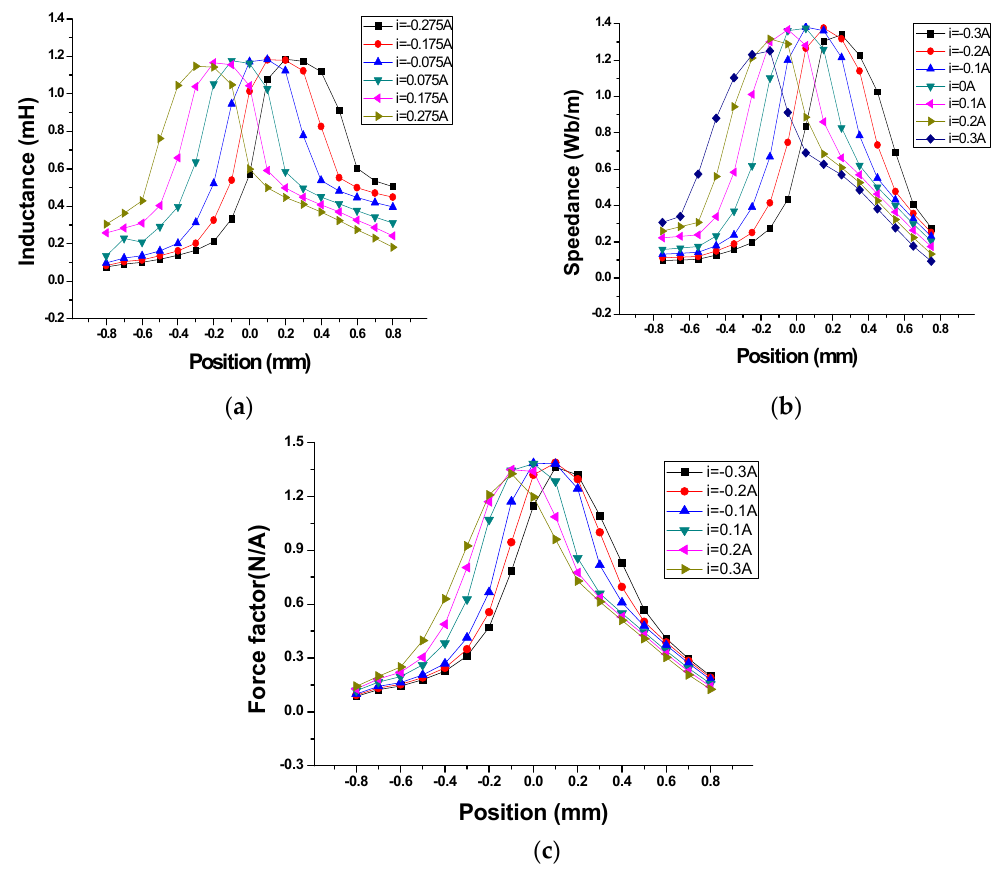
Figure 4. ( a ) Inductance; ( b ) speedance; ( c ) force factor.